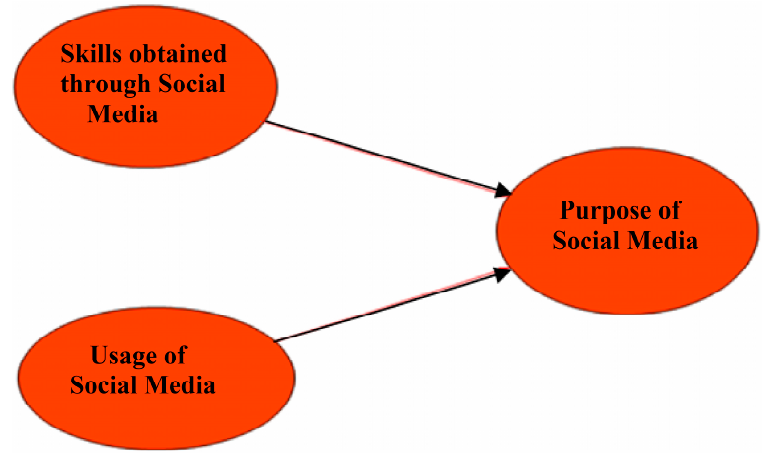
Figure 3. Conceptual model for assessing the relationships among the skills obtained through social media, the usage of social media, and the purpose of social media.